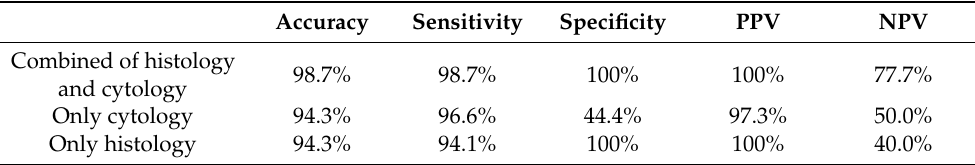
Table 4. Diagnostic results of EUS-FNB.